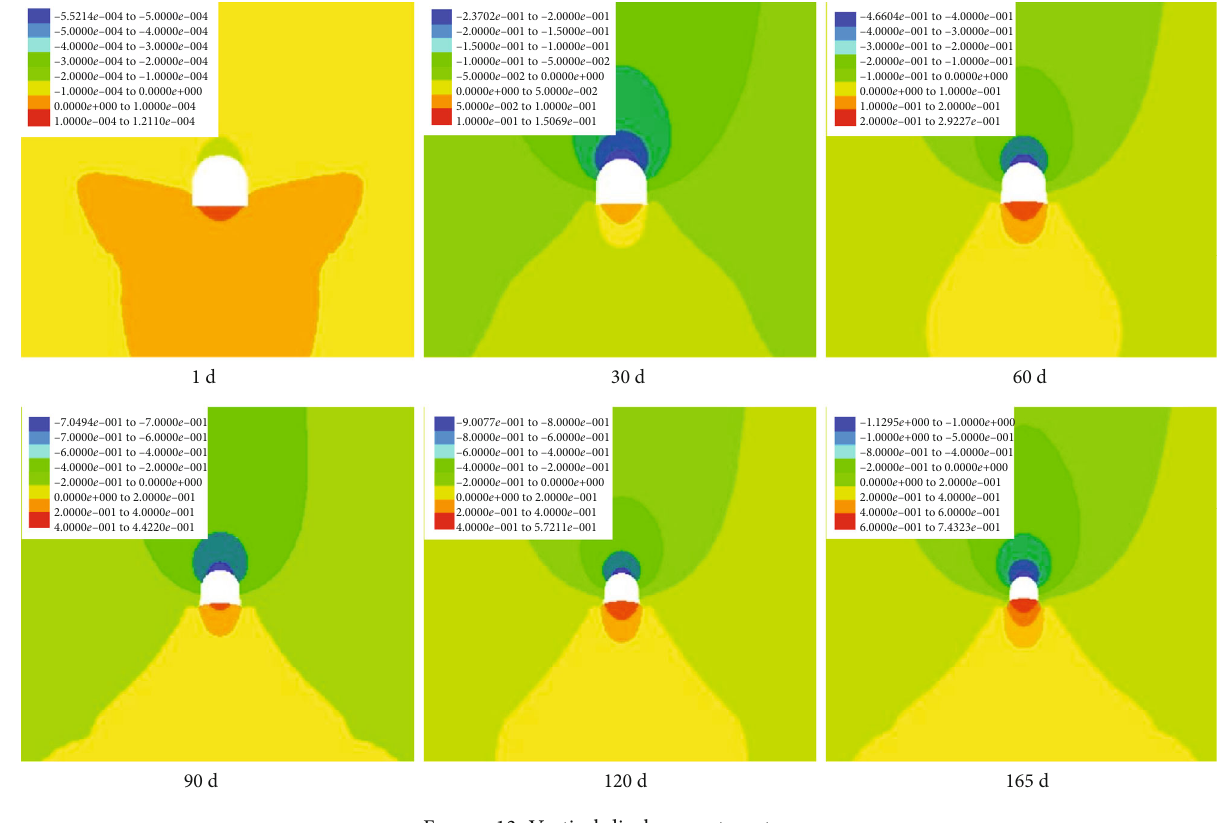
Figure 13: Vertical displacement contours.